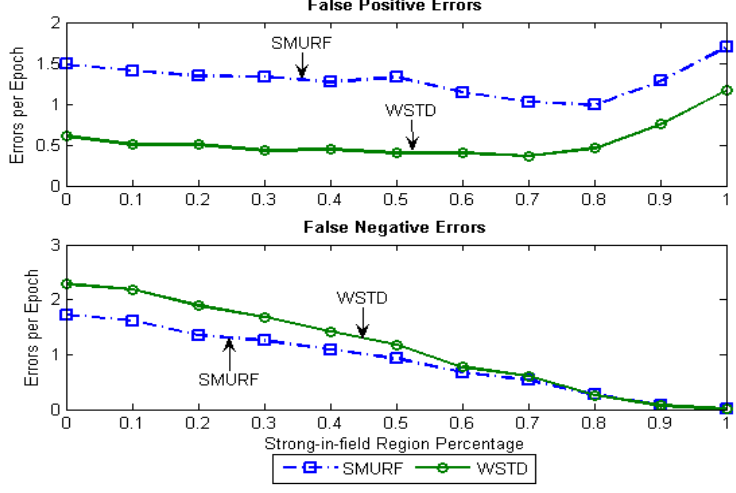
Figure 9. WSTD and SMURF schemes’ false positive and false negative error contribution as the environment noise is varied.